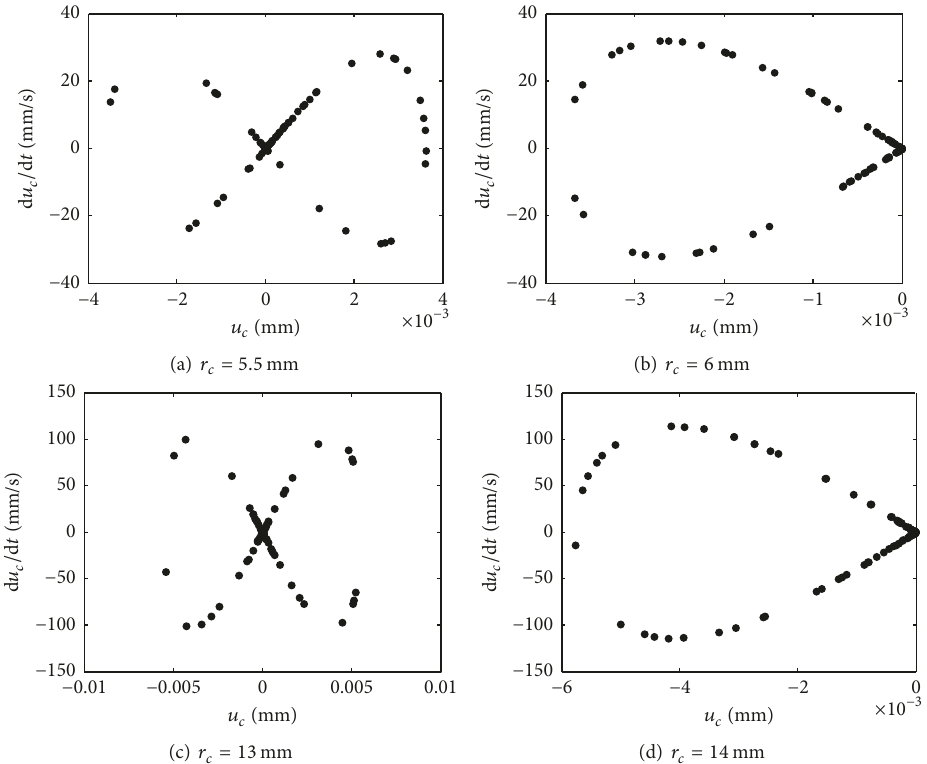
Figure 11: Poincare map of vibration response of rigid cog for different theoretical